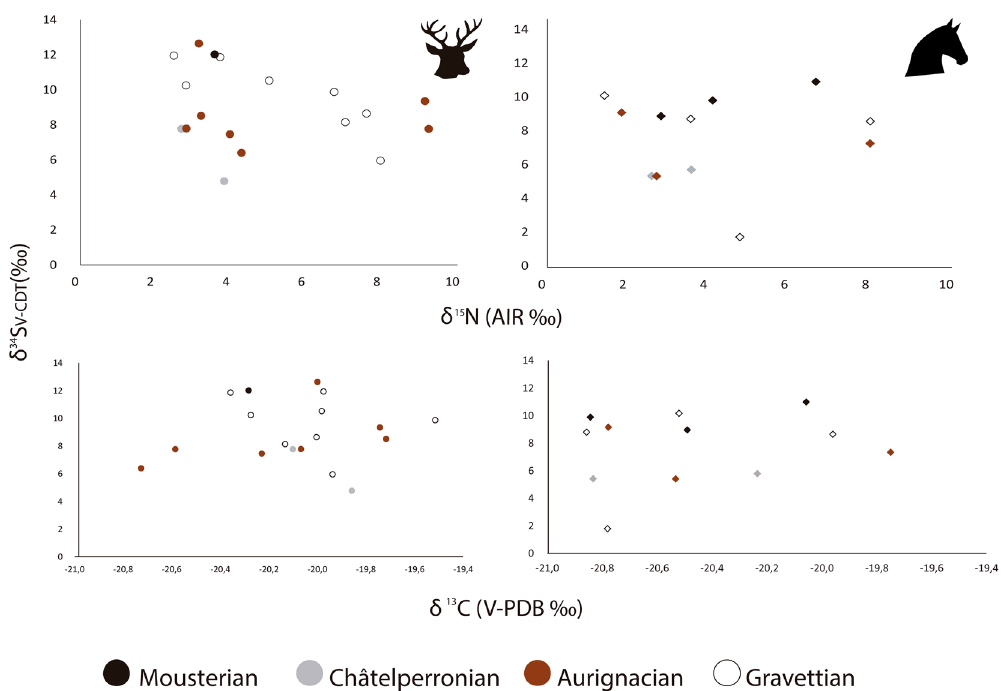
Figure 6. Bone collagen δ 34 S values plotted with the δ 15 N values (above) and δ 34 S values and δ 13 C values (below) for each of the cultural periods sampled within the eastern Cantabrian region. Red deer values are plotted in the graphs on the left (denoted as circles) and horse values are plotted on the right (denoted as